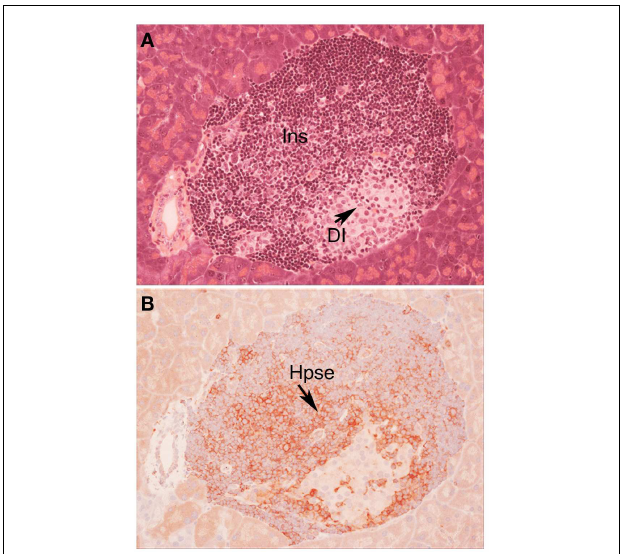
FIGURE 1 |AutoimmuneT1D in NOD/Lt mice is characterized by cell surface expression of heparanase on insulitis leukocytes . Histology (A) and immunohistochemistry (B) of a pancreatic islet in a NOD/Lt female mouse at the time ofT1D onset shows islet infiltration by destructive heparanase (Hpse)-expressing insulitis leukocytes (B) localized particularly at the insulitis-islet interface, a process which leads to loss of beta cell HS and beta cell death. (A) hematoxylin and eosin; (B) HP130 anti-heparanase mAb. Ins, insulitis mononuclear cells; DI, damaged islet tissue; Hpse,